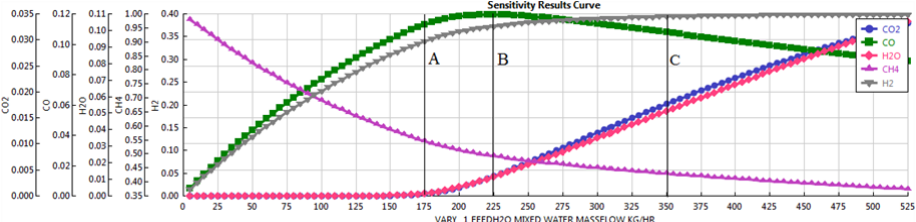
Figure 2. SMR sensitivity results (SMR molar fractions vs. H 2 O feed). Lines A, B and C correspond to the H 2 O flow rates of 175, 225 and 350 kg/h, respectively.